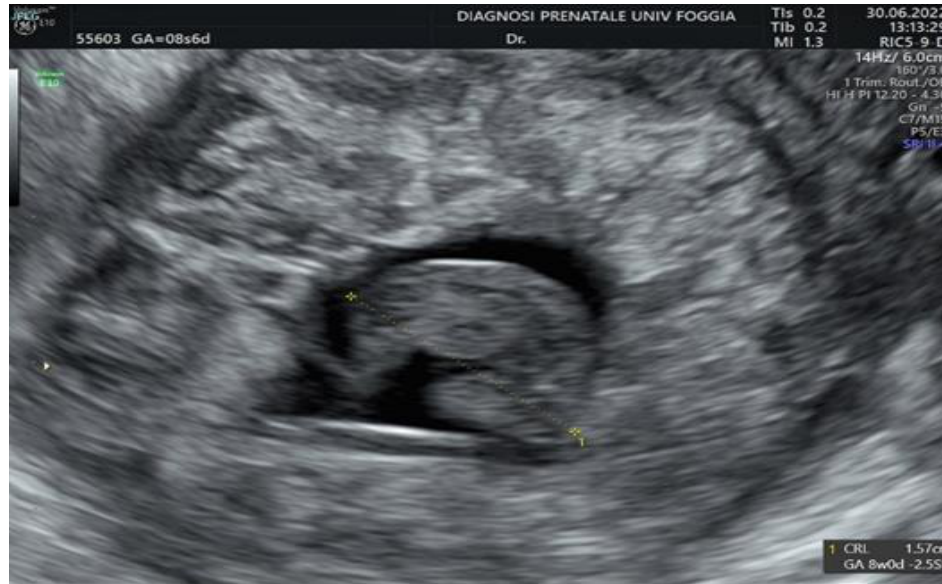
Figure 6. Embryo with no cardiac activity on day 15.